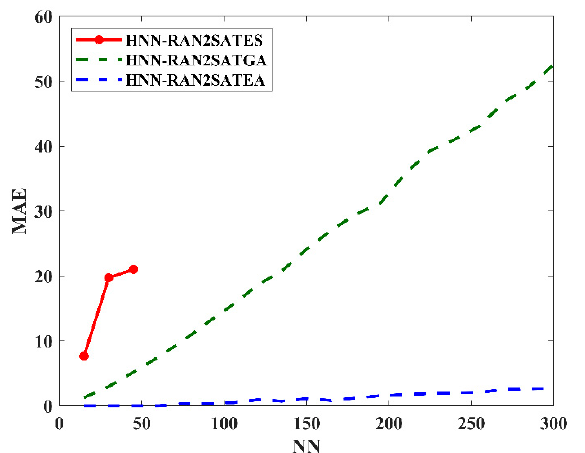
Figure 3. Mean absolute error (MAE) evaluation of various HNN-RAN2SAT models.